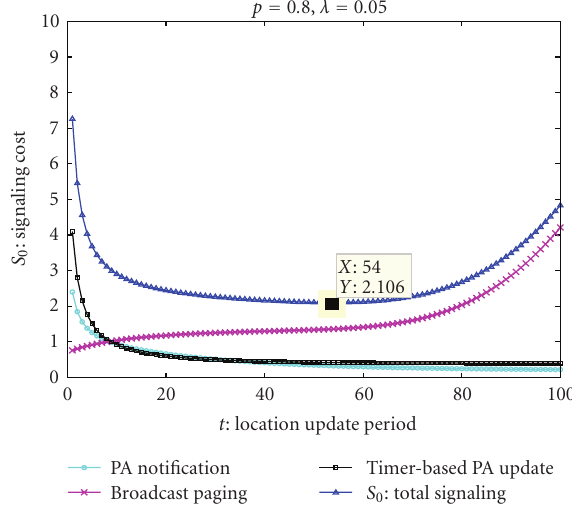
Figure 15: Signaling cost: low mobility and low message arrival rate.